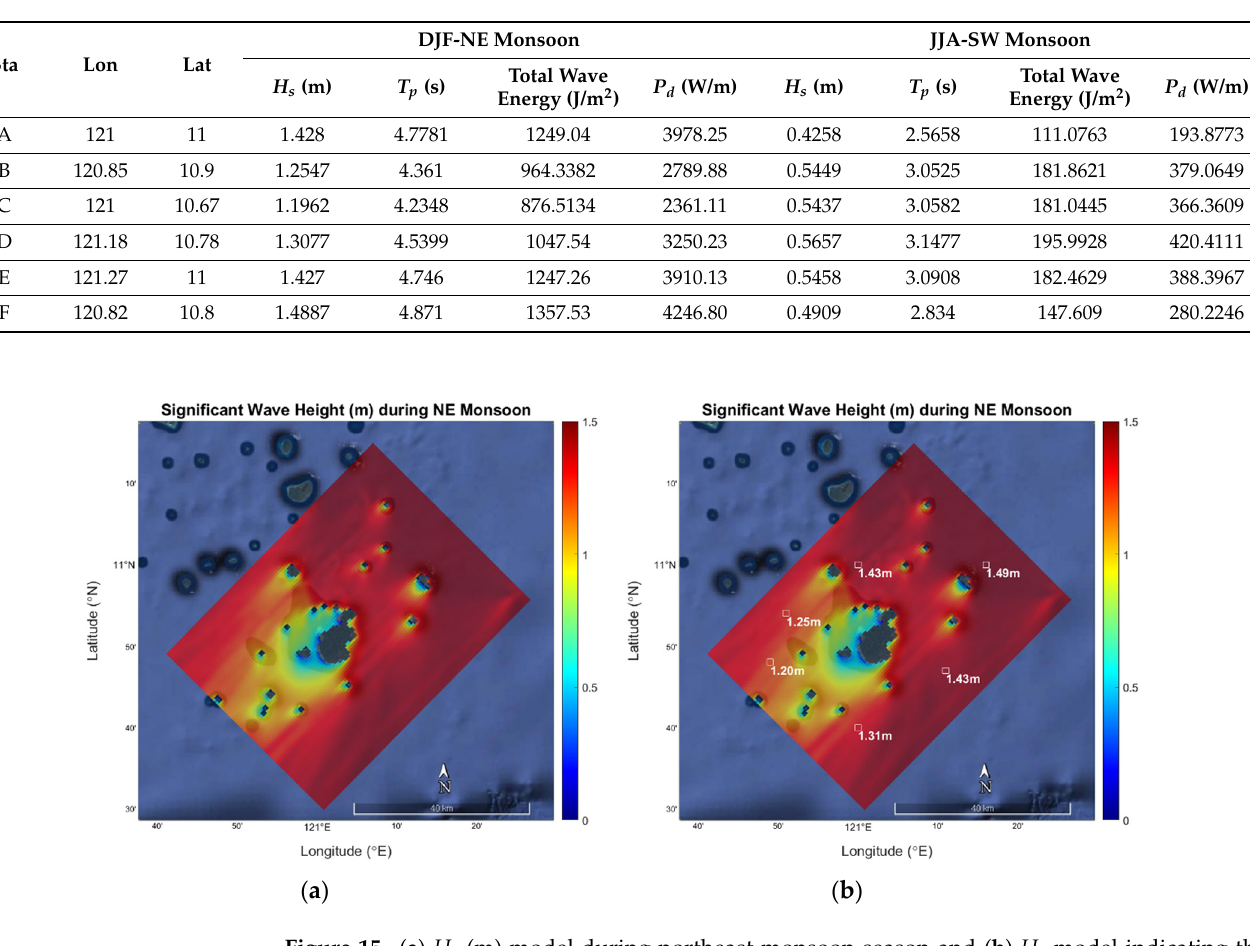
Figure 14. Location of the six (6) points of interest within the model domain (stations A–F). Table 4. Summary results of wave parameters for the NE and SW monsoons at the six (6) points of interest near the island (simulated using MOV data).